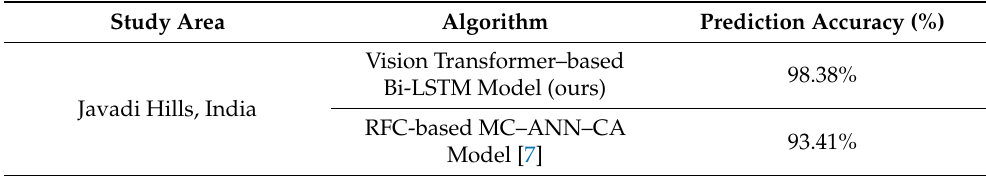
Table 12. Comparative analysis of LU/LC prediction models for the area of Javadi Hills, India.